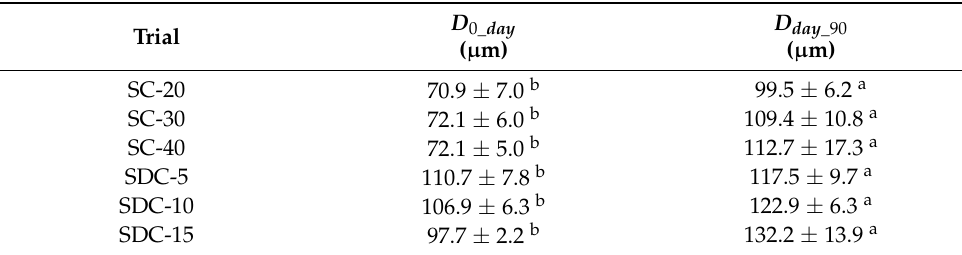
Table 3. Volume-weighted mean diameter ( D 4,3 ) of the microparticles measured on days 0 and 90 of storage, at 25 ◦ C and 33% RH